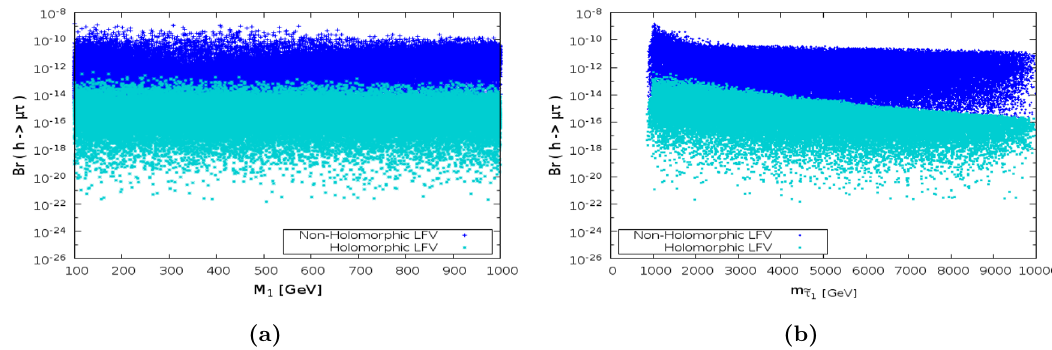
Figure 7. In left panel of (cid:12)gure 7 we can see the dependence of Br ( h right side the same branching ratio is plotted against the lightest slepton mass. All other soft mass parameters and trilinear couplings are according to table 3 and are checked through the charge breaking minima